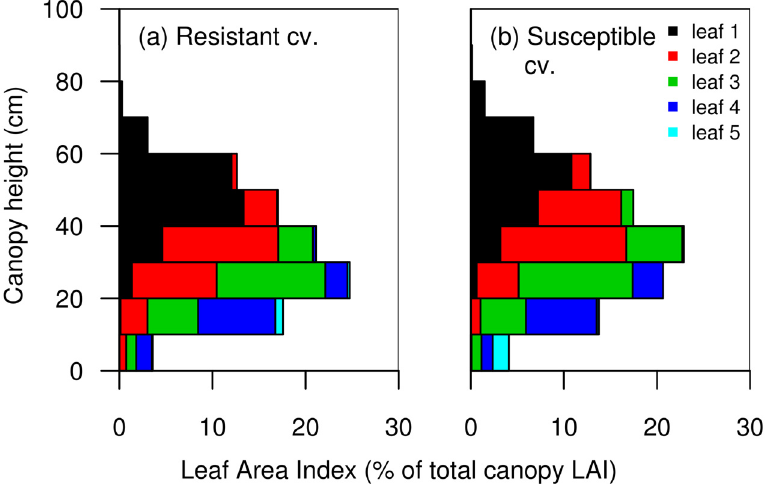
Fig 3. Vertical distribution of leaf area index (leaf area per area of ground). Vertical distributionof LAI was estimated from 3D mock-ups of two wheat cultivars either resistant (a) or susceptible(b) to STB, for each leaf rank. Values were expressedas a proportionof total leaf area index of the canopy. Leaves were numbered from the top to the bottom of the plant. Leaf 1 correspondsto the flag leaf (highest leaf).